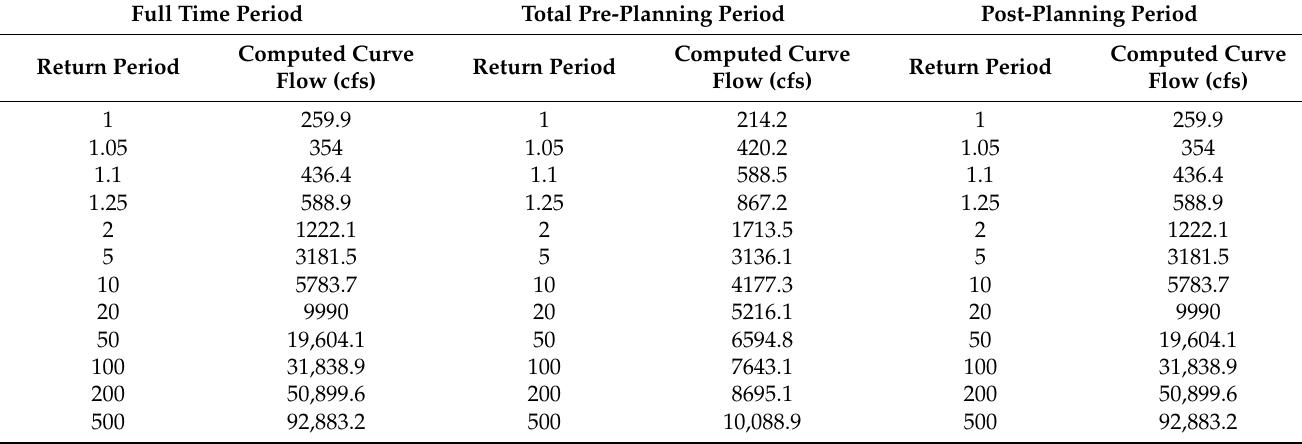
Table A2. Return periods and their corresponding computed curve flows for the two halves of the pre ‐ planning period.